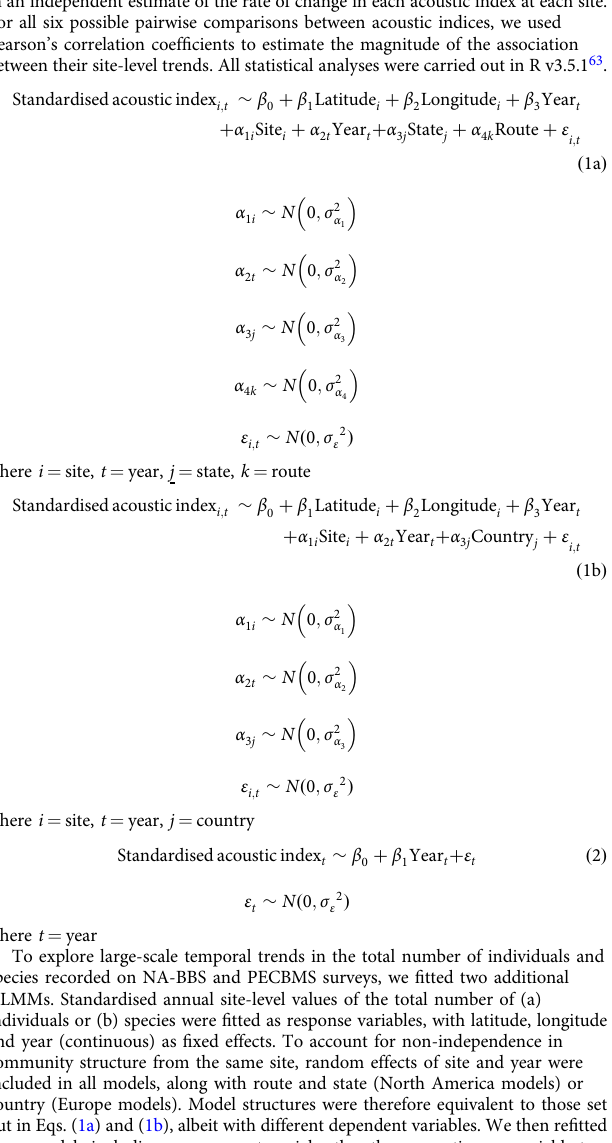
out on the original site-level estimates, as well as the proportion of times each fi xed